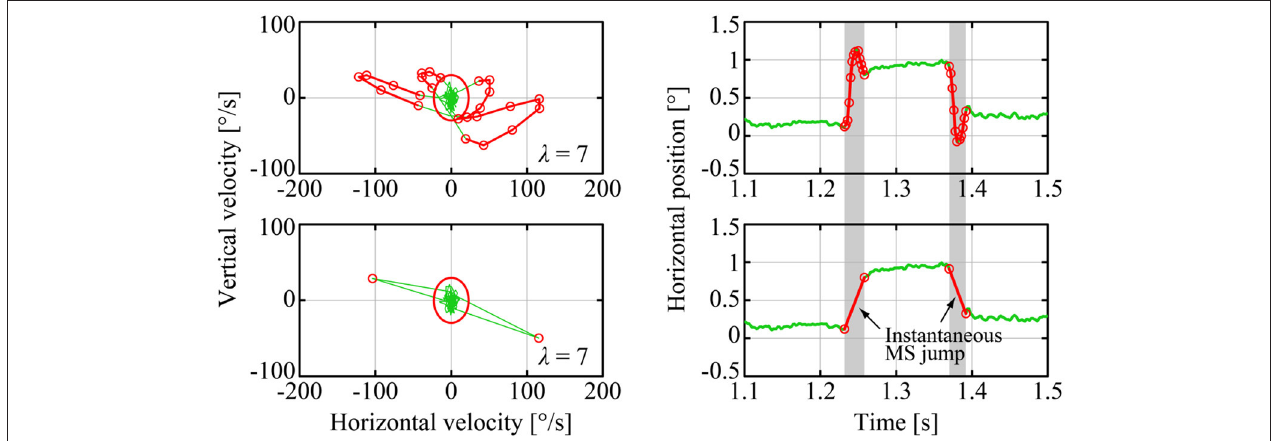
FIGURE 3 | Detection and simplification of MS events. The upper panels show an example of raw-GZ data with an MS event detected by the Engbert and Kliegl (E&K) method in the v x − v y plane (left panel) and the corresponding time profile (right panel), where the red curves are MS components and the green curves are DRT components. The lower panels are for the corresponding GZ data, in which MS events were simplified, referred to simply as MS in this paper, by eliminating the transient and overshoot ballistic components from the raw-MS waveforms for further analysis performed in this